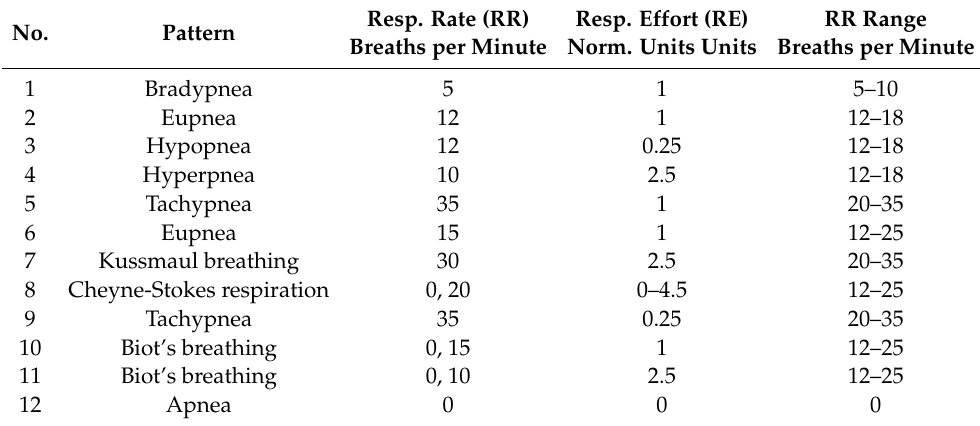
Table 1. Pattern description of the breath-protocol, shown in Figure